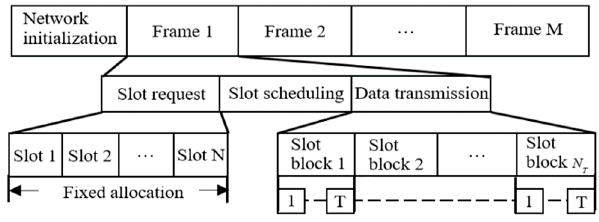
Figure 1. Frame Structure of CEH-TDMA.